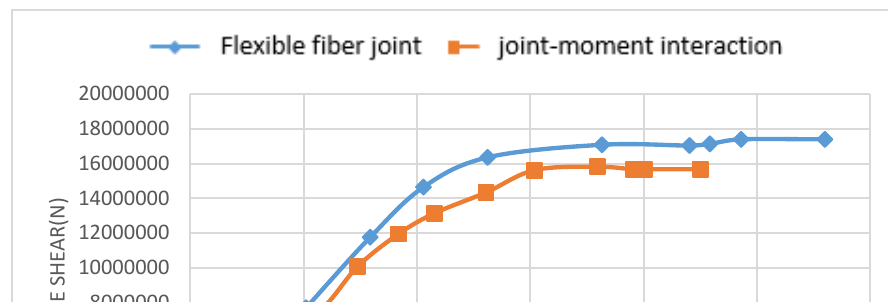
Fig. 19. Longitudinal direction of the bridge.